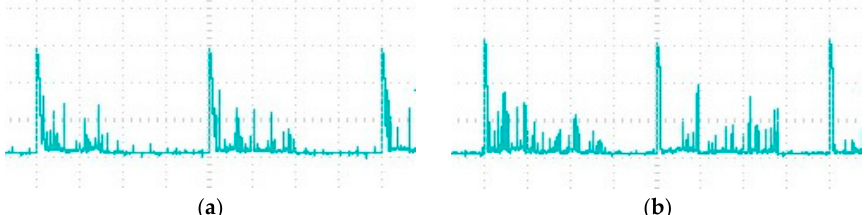
Figure 12. Current waveforms under different duty factors. ( a ) Duty factor 50%. ( b ) Duty factor 70%.